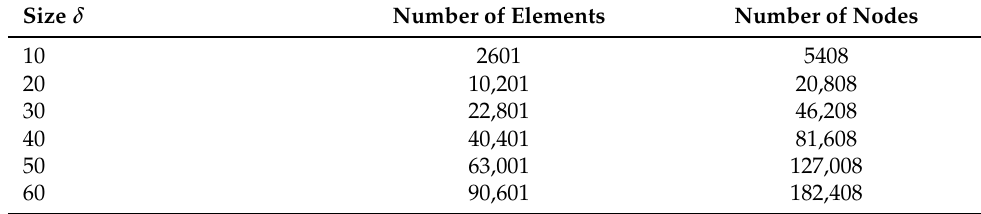
Figure 15. Eight-node linear hexahedral elements with reduced integration of type C3D8R available on ABAQUS ® . Table 6. Finite element discretization